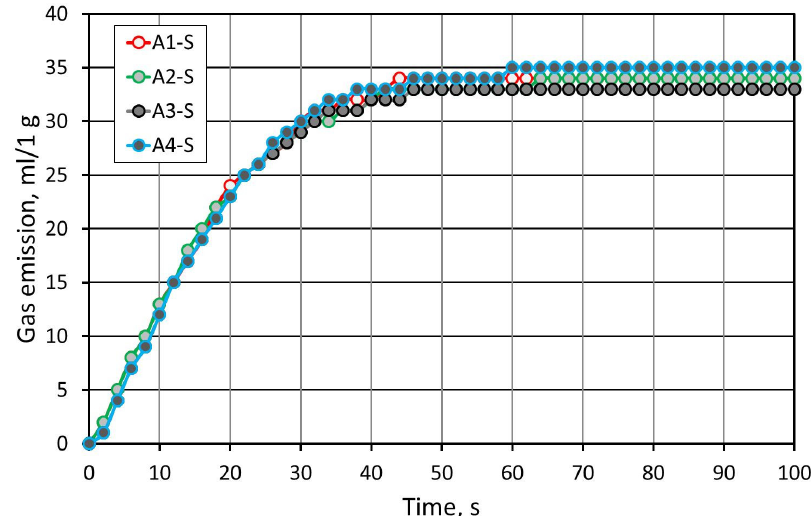
Figure 7. Comparison of the gas emissivity of the molding sand carried out on SIBELCO (S) sand with various binders in alkali-phenolic process for the constant resin content of 1.2 wt.% and 25% of hardener.